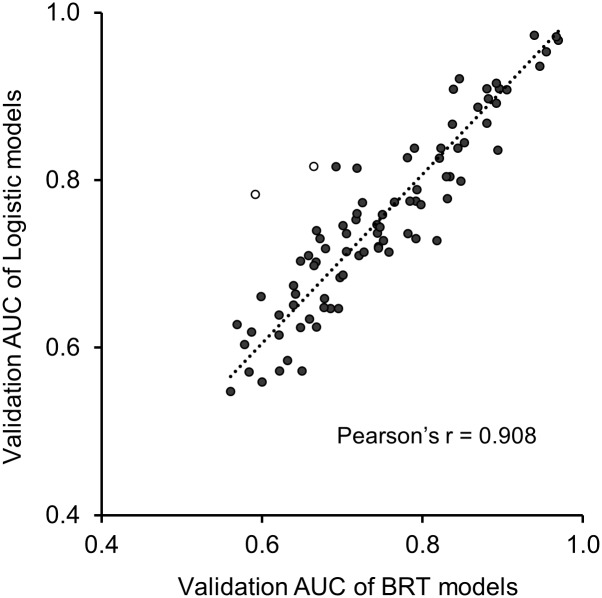
Comparing the performance of Lasso logistic regression model and boosted regression tree (BRT) models in terms of the area under the receiver-operating-characteristic (ROC) curve in the 5-fold cross validation for 76 species in the four selected river basins (i.e., New River, Illinois River, Brazos River and Snake River).The results from the two set of models were generally in agreement, with Pearson’s r over 0.9. For fish species Mountain whitefish, Prosopium williamsoni and Torrent sculpin, Cottus rhotheus (marked as circles) in the Snake River where occurrence data was relatively sparse, the Lasso logistic models outperformed the BRT models.